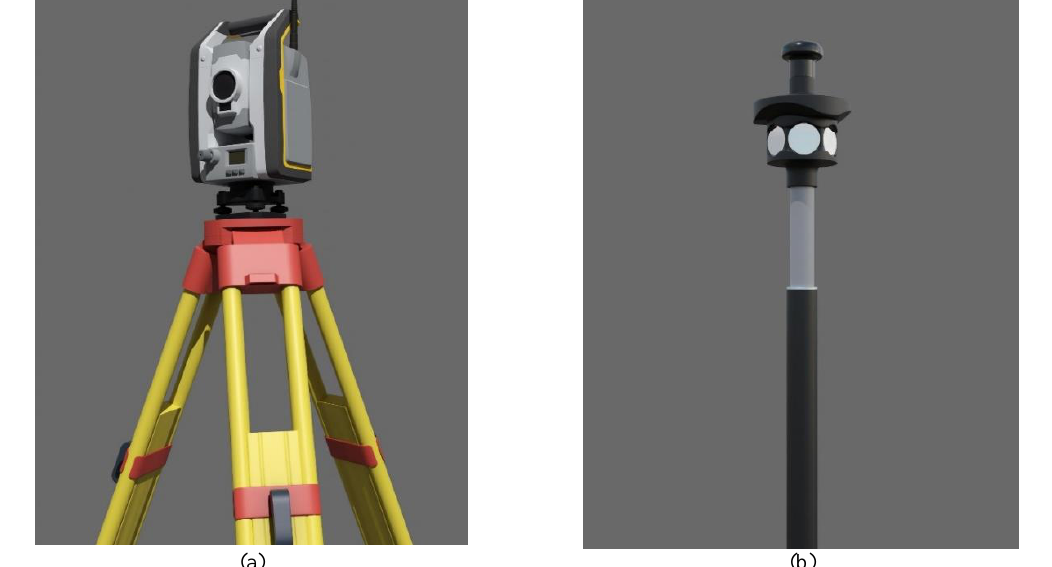
Figure 2. Virtual total station model based on Trimble S7 ( a ) and rod/reflector model ( b ) in Blender.